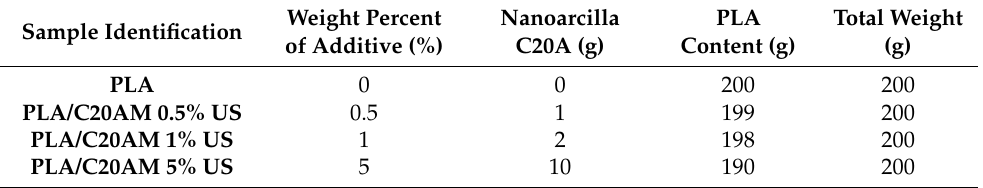
Table 2. Compounding formulations of poly (lactic acid)/cloisite 20A prepared by ultrasound- assisted melt extrusion